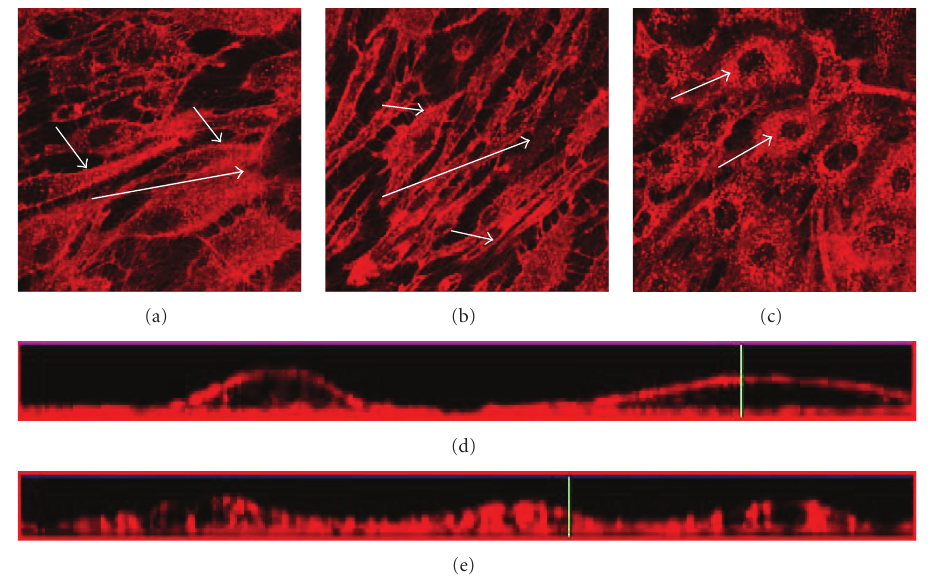
Figure 1: E ff ects from flow on the thickness and integrity of the glycocalyx layer of PAEC exposed to flow shear stress at 11dynes/cm 2 and under static conditions for control. The glycocalyx layer is visualized under the confocal microscope through staining of heparan sulfate with Texas Red-conjugated lectin after di ff erent times in culture. (a) Cells exposed to flow shear stress for 24 hours, (b) cells exposed to flow shear stress for 48 hours, and (c) cells grown under static conditions for 24 hours. The images are cross-sections of the cell monolayer z = 0.5–2 µ m with z = 0 at the glass surface. Large arrows indicate approximate flow directions. Small arrows indicate the distribution of the stain, predominantly located in the interior of the cells not exposed to shear stress compared to the shear-exposed cells where it is most abundant at the surface. Figures 1(d) and 1(e) are the cross-sections from the side of the stack of images created with confocal microscopy with (d) cells exposed to shear stress for 24 hours and (e) cells grown under static conditions for 24 hours.